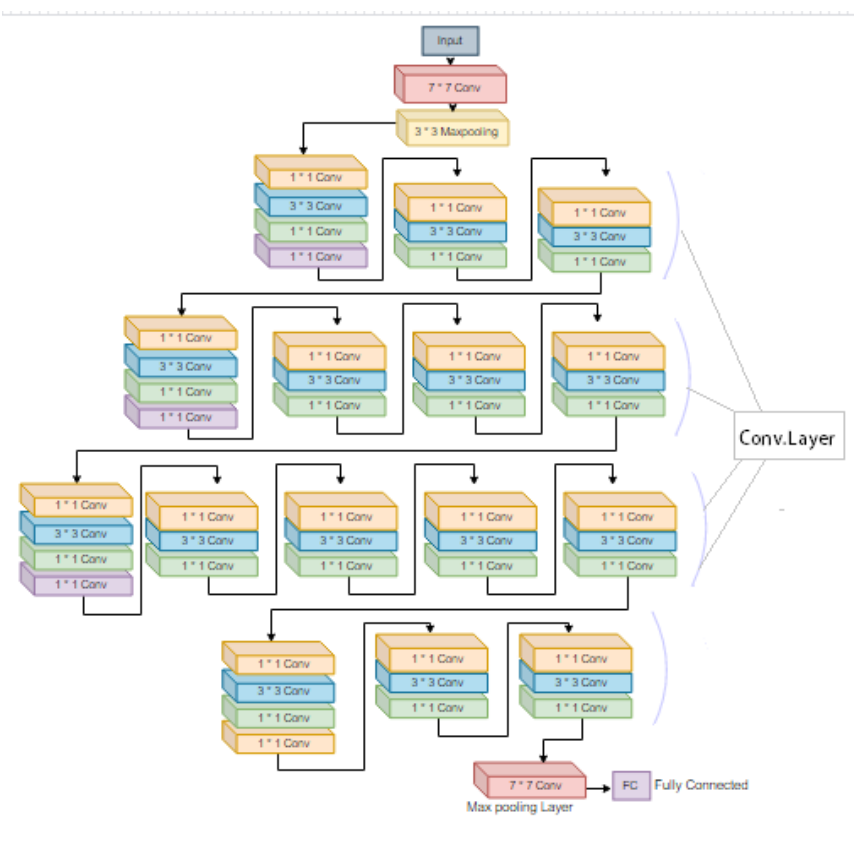
Figure 11. ResNet50